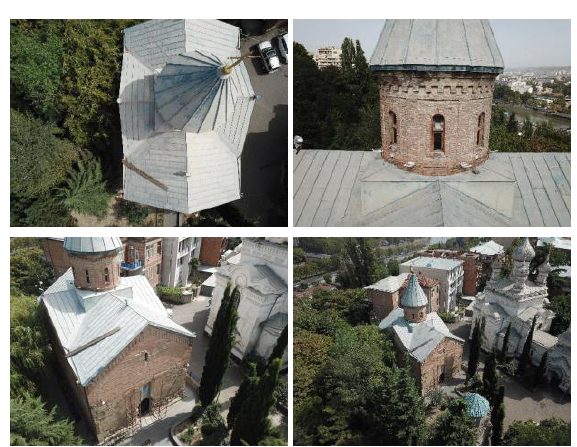
Figure 7. Example images of UAV